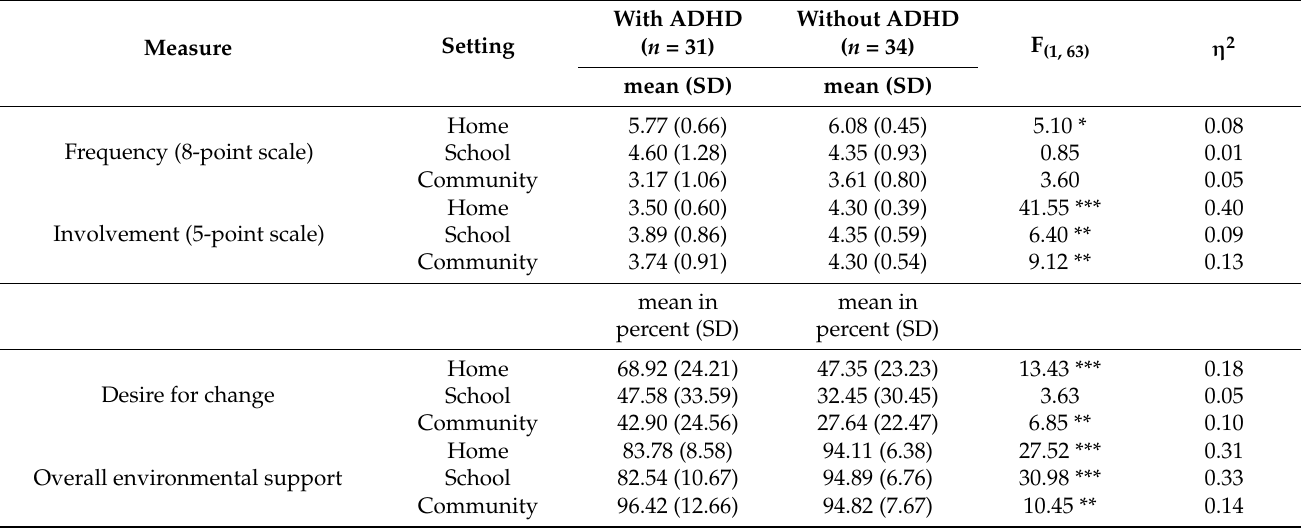
With ADHD Without ADHD ( n = 31) ( n = 34) F (1, 63) mean (SD) mean (SD)